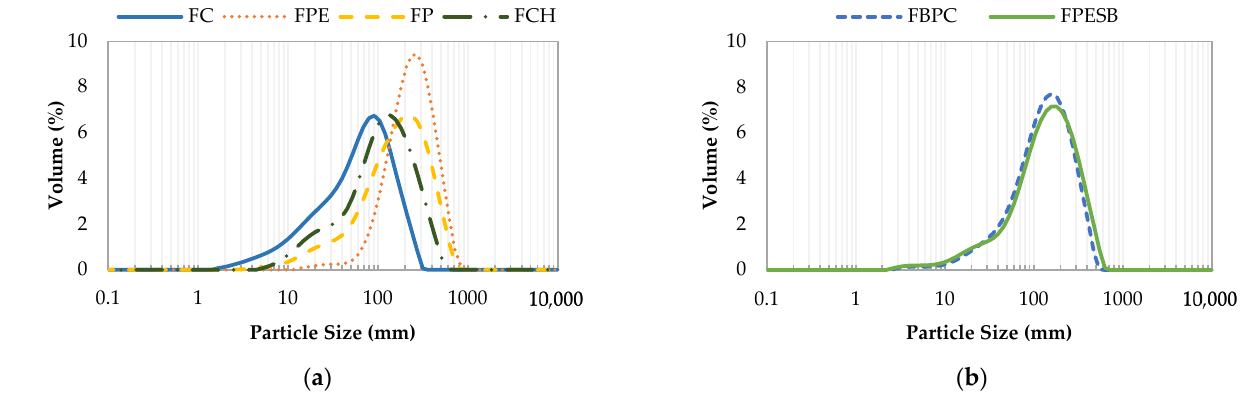
Figure 1. Volume of the particle size distributions (representative curves) of the studied fibers, where ( a ) presents the vegetable DF samples of one different source and ( b ) denotes the samples made with a combination of vegetable